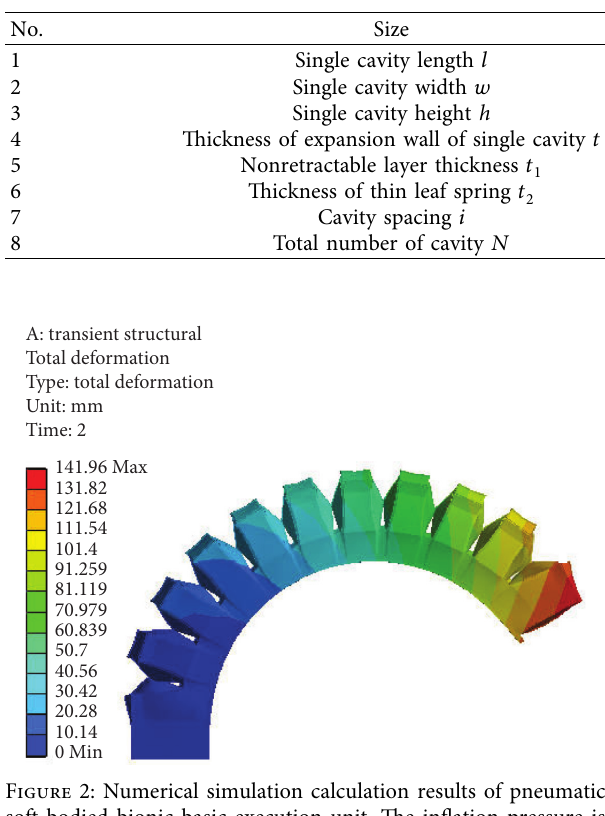
Figure 1: Structure design of pneumatic soft-bodied bionic basic execution unit. (a) 3D digital model. (b) Longitudinal local cross section. (c) Transverse local cross section. Table 1: Dimensions of pneumatic soft-bodied bionic basic exe- cution unit.